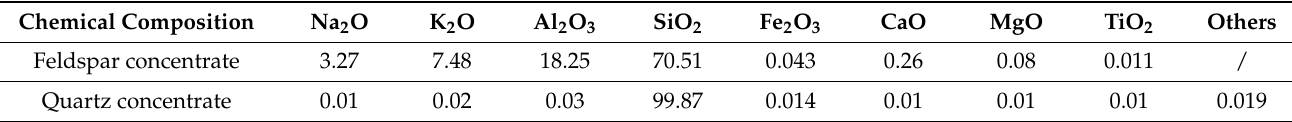
Table 13. Chemical compositions of feldspar and quartz concentrates (mass fraction, %).